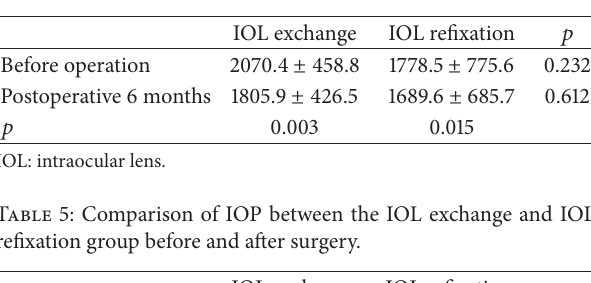
Table 4: Comparison of endothelial cell density between the IOL exchange and IOL refixation group before and after surgery.